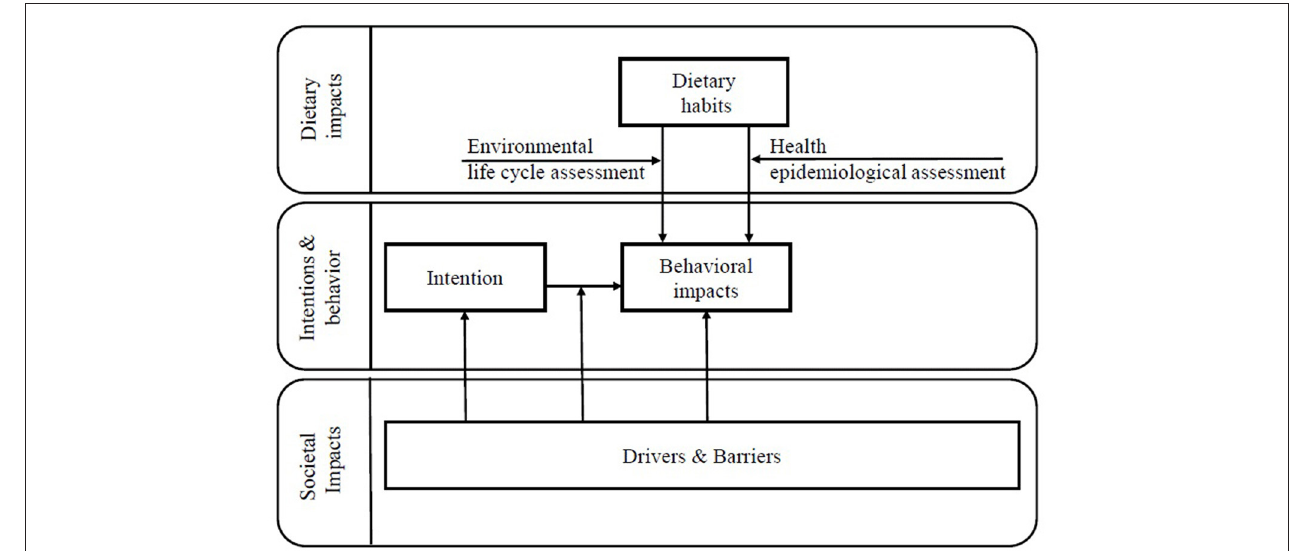
FIGURE 1 | Conceptual